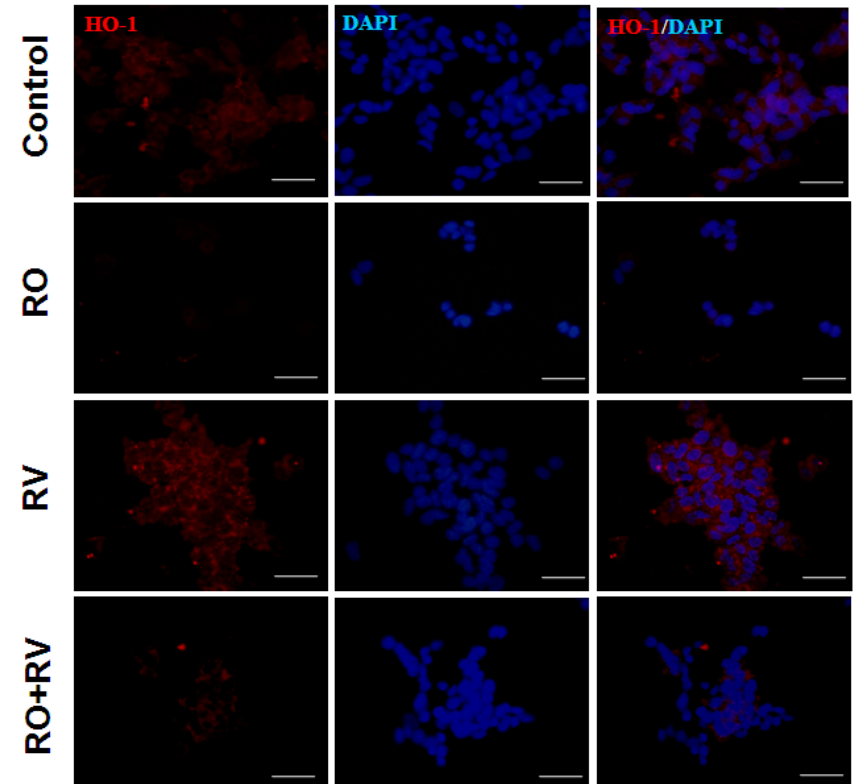
Figure 5. Rotenone-mediated inhibition of HO-1 expression is prevented by resveratrol. SH-SY5Y cells were pretreated with/without 20 μ M resveratrol for 24 h then treated with/without 20 μ M rotenone for the next 24 h. ( A , B ) HO-1 expression (red) was determined by fluorescence microscopy and quantified using Image J. Nuclei were observed by DAPI (blue) staining. Scale bar, 50 μ m; ( C , D ) HO-1 expression was determined by immunoblotting followed by quantitative analysis using Image J. Data were normalized to glyceraldehyde-3-phosphate dehydrogenase (GADPH) levels. RO, rotenone; RV, resveratrol. Data (mean ± SEM) are representative of at least three independent experiments. Statistical significance was determined by one-way analysis of variance followed by Bonferroni post-hoc test. # p < 0.05 compared between groups. * p < 0.05 compared to